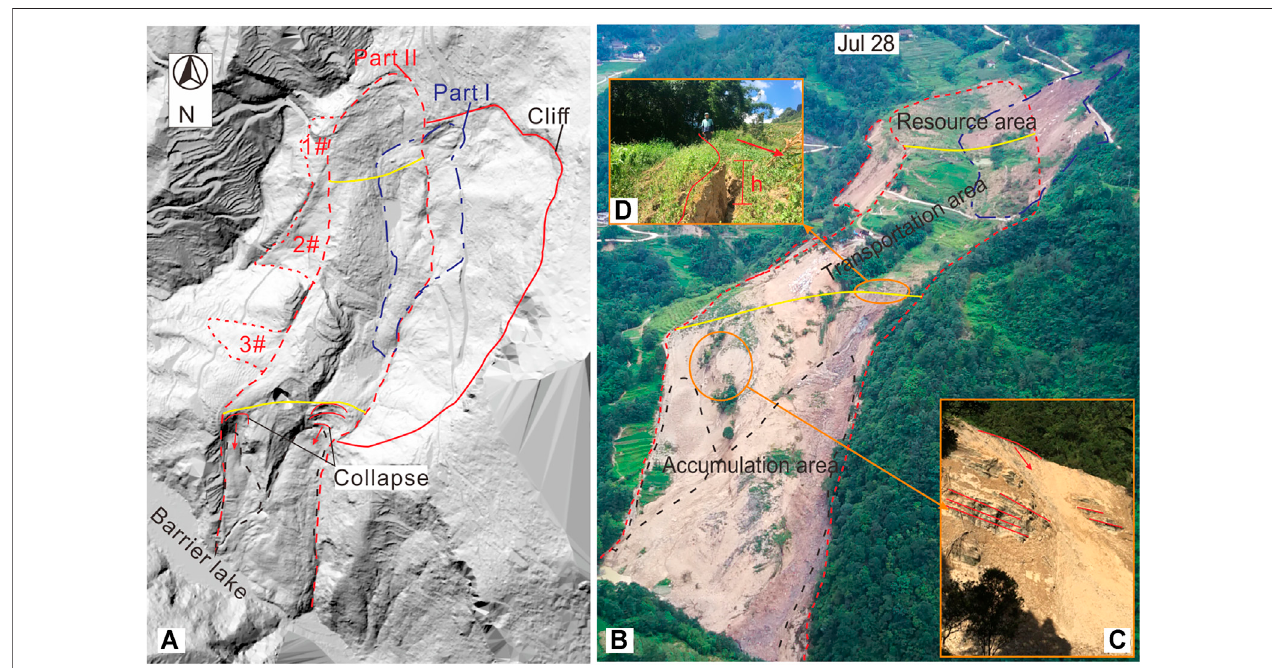
FIGURE 5 | The result of the Airborne Lidar after fi ltering out trees. Note the black dashed line is the secondary landslide in the accumulation area. Yellow lines separate the three parts (see text). Sub-photographs are the scarplet and local collapse, respectively.